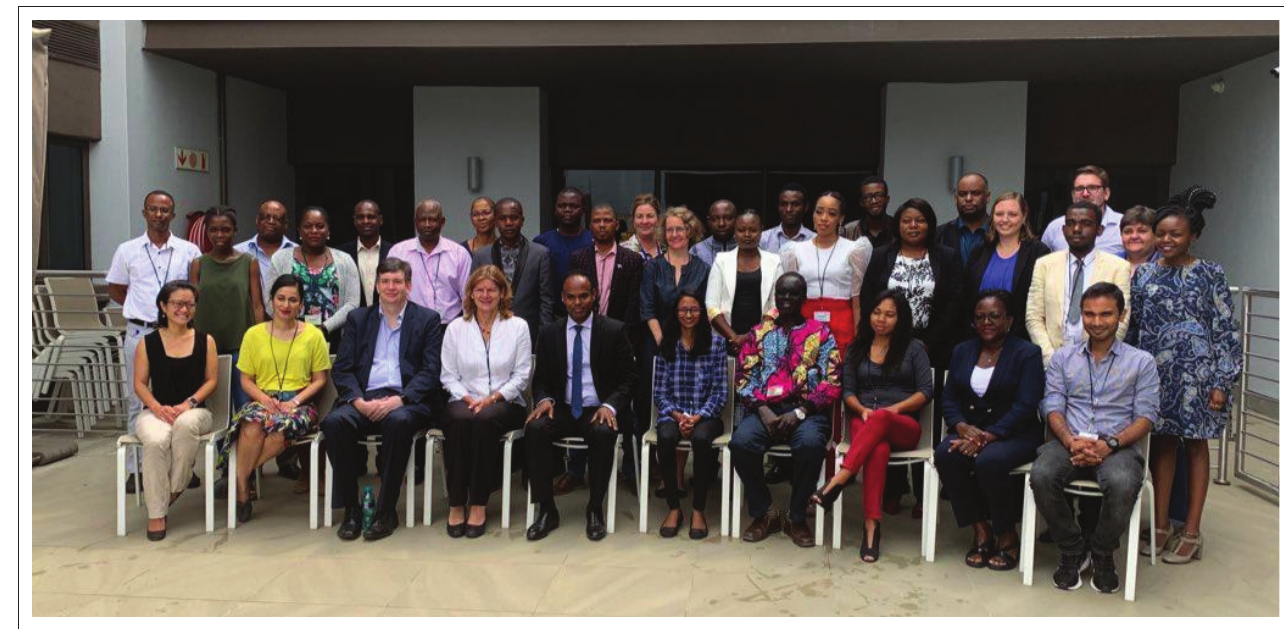
FIGURE 3 : Second training on laboratory diagnosis of COVID-19, South Africa, 21 February